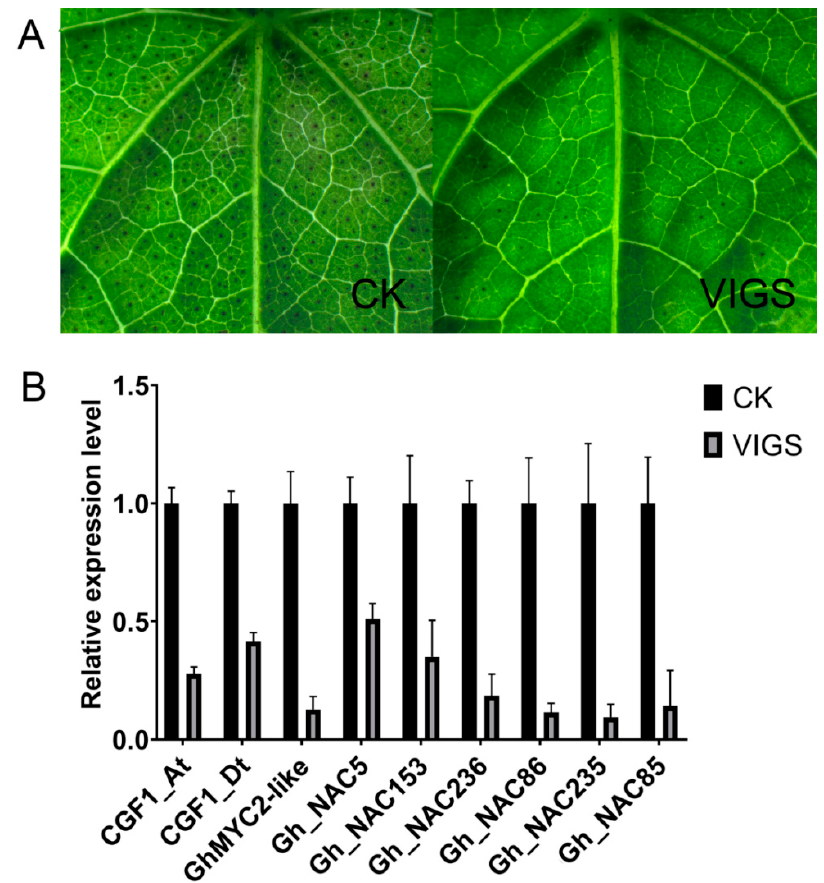
Figure 9. Silencing CGF1 causes glandless phenotype and down-regulated expression of GhMYC2-like and 6 NAC genes (reference gene: actin). ( A ) Phenotype of VIGS plants. ( B ) Expression analysis of CGF1 , GhMYC2-like and 6 NAC genes by qRT-PCR. CGF1_At: CGF1 from A subgenome, CGF1_Dt: CGF1 from D subgenome.